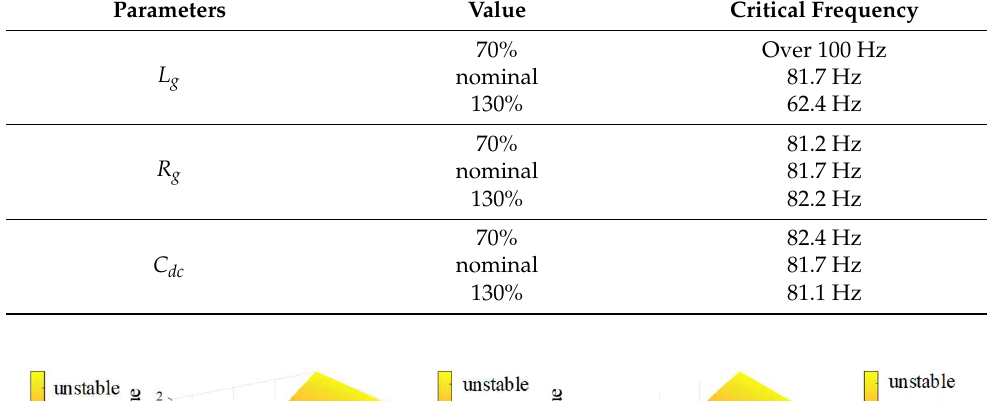
Figure 4. A L eigenvalues as a function of the ac main frequency (from 30 to 100 Hz); ( a ) all six values; ( b ) zoom to the unstable eigenvalues. Table 2. Critical frequency for static decoupler. Table 2. Critical frequency for static decoupler.